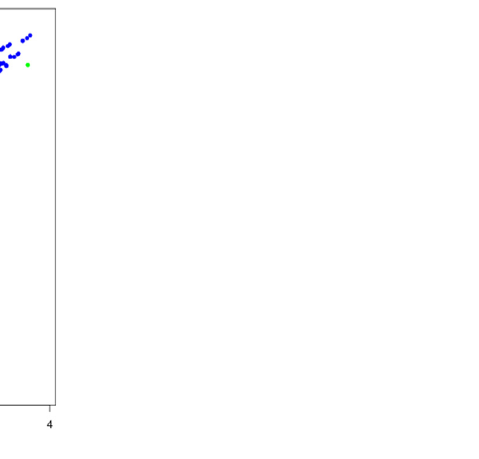
Fig 6. The gene expression level of chrysanthemum between the two libraries (Sample_0510_control and Sample_0510_treat). Red dots represent transcripts more prevalent in the library of salt-treated one, green dots show those present at a lower frequency in salt-treated chrysanthemum and blue dots indicate transcripts that did not change significantly.